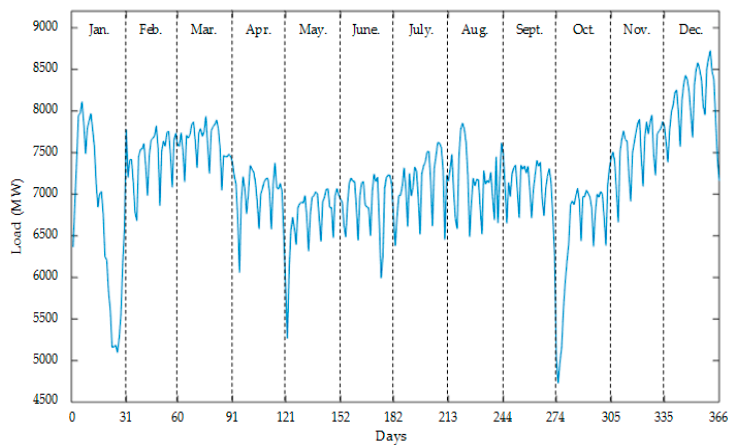
Figure 2. Load curve of the entire year.